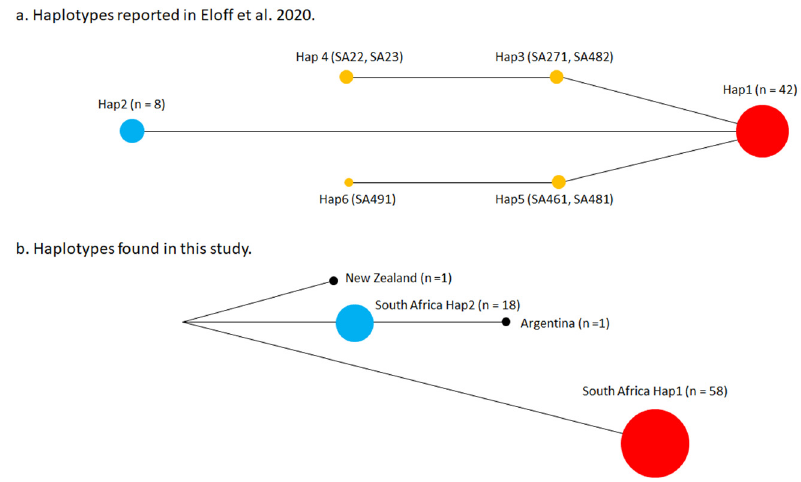
Figure 6. Median-joining networks of mitochondrial haplotypes of Vespula germanica ( a ) found in South Africa in a previous study [9] and ( b ) found in South Africa, Argentina, and New Zealand in our study. The length of the branches is proportional to the number of nucleotide substitutions between haplotypes.